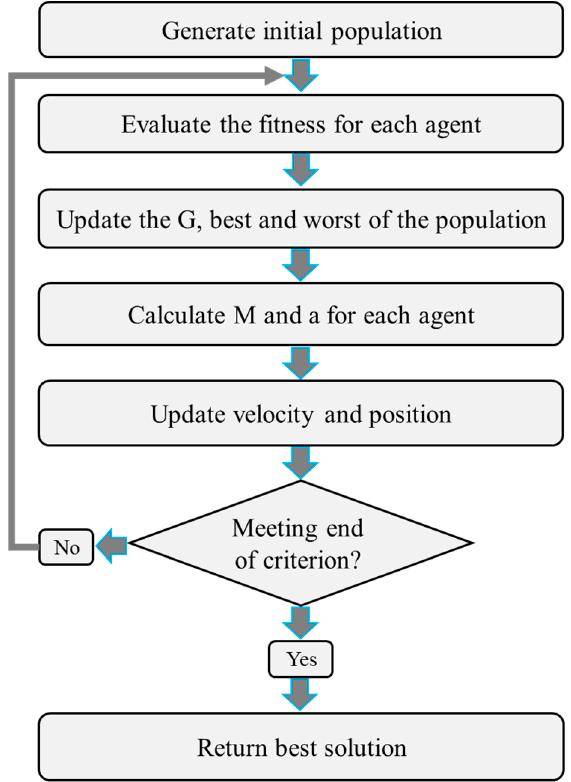
Figure 2. The optimization algorithm.